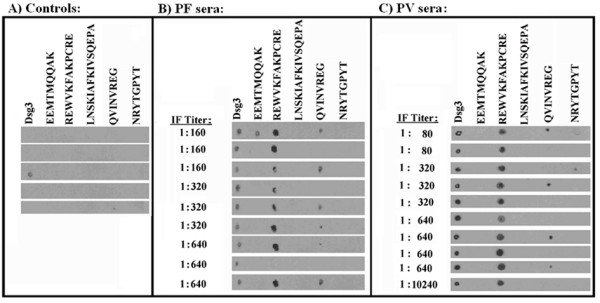
Immunoreactivity of PV, PF or prostate cancer human sera towards EC Dsg3 peptides. Sera: A) control sera from prostate cancer patients; B) Pemphigus foliaceous sera; C) Pemphigus vulgaris sera. Immunoreactivity of each serum was assayed by dot-blot as described under Methods. Indirect IF titer is reported for each PF and PV serum. Antigens: Dsg3, recombinant EC Dsg 3 protein; peptides with low redundancy to the human proteins: Dsg336–44EEMTMQQAK and Dsg349–60 REWVKFAKPCRE; peptide with high affinity to DRB*0402: Dsg3190–204LNSKIAFKIVSQEPA; control peptides: Dsg3373–380QVINVREG and Dsg3518–525NRYTGPYT.